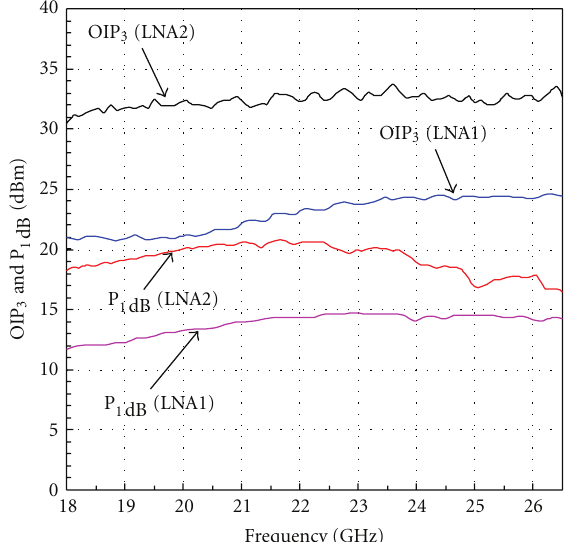
Figure 7: Measured P 1dB and OIP 3 of the dual-LNA MMIC with subcircuits LNA1 and LNA2 designed for low NF and high linearity,